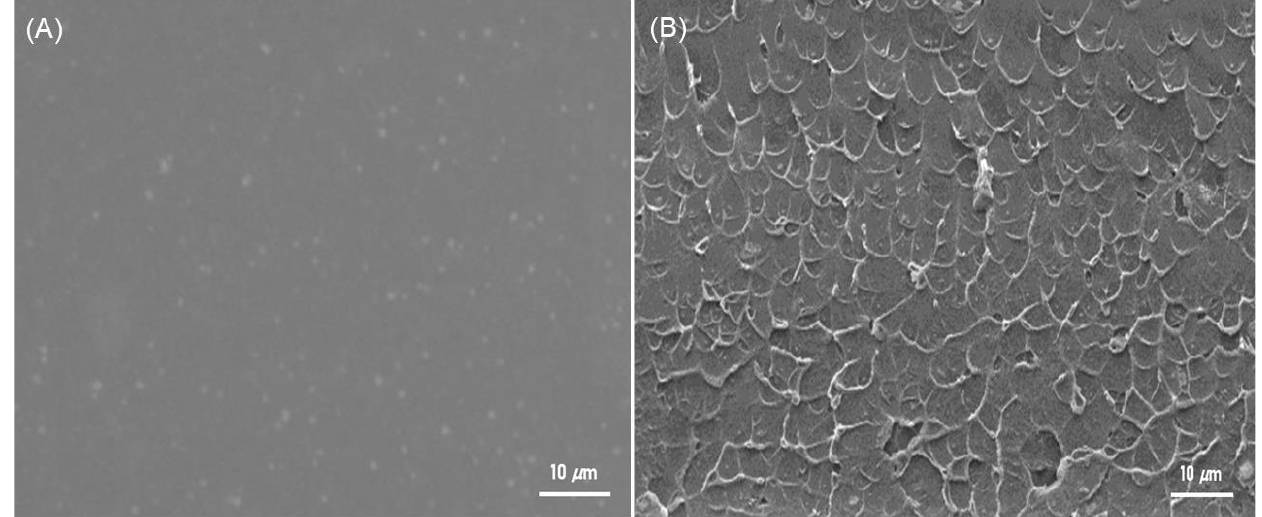
Figure 7. The images in ( A ) show plain Na-Alg membranes, and ( B ) have ZIF-8-filled NCMs.